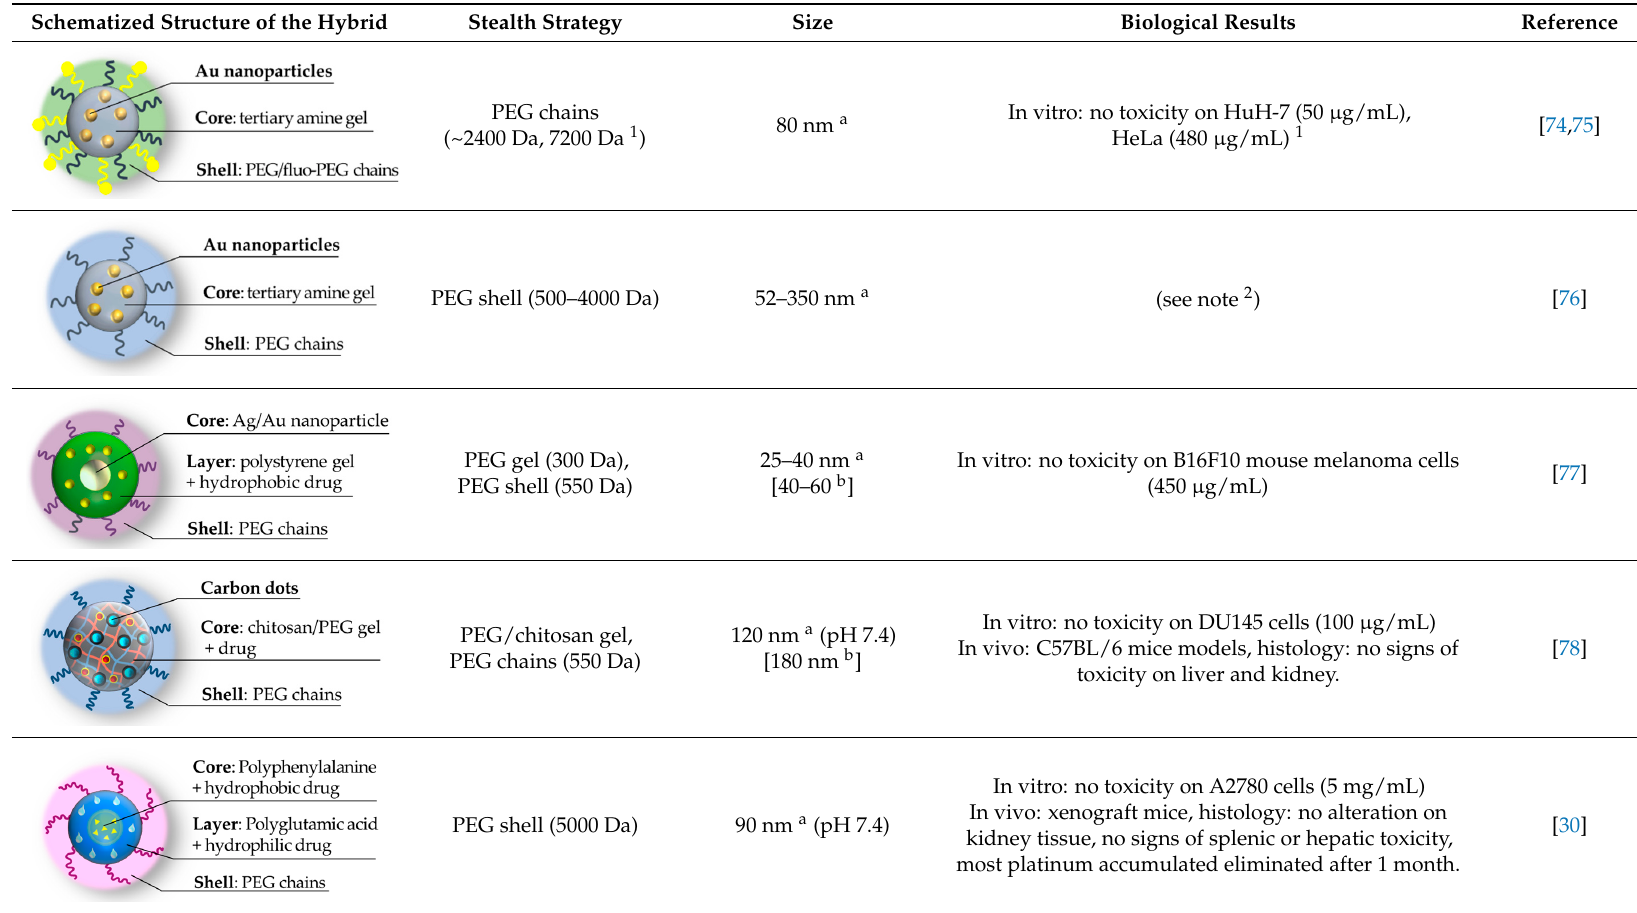
Table 1. The main morphologies of the described nanogels with summarized the biological outcomes.